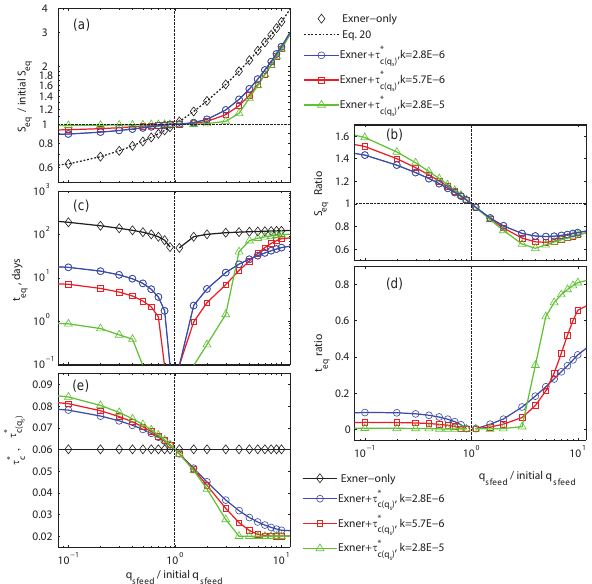
were c( q s ) Figure 8. Morphodynamic model sensitivity to sediment supply perturbations and k . All models started at the same equilibrium con- dition as shown in Figs. 6 and 7. (a) Slope adjustment, normalized by the initial equilibrium slope. The correspondence of Eq. (20) and the morphodynamic model calculations demonstrate that the models did asymptotically attain equilibrium slopes. (b) S eq ratio is the ratio of equilibrium slopes of the Exner + τ ∗ model di- c( q s ) vided by S eq for the Exner-only model, to show the relative af- fect that τ ∗ c evolution has on equilibrium slopes. (c) Equilibrium timescales for model adjustment. (d) t eq ratio is the ratio of t eq for the Exner + τ ∗ model divided by t eq for the Exner-only model. c( q s ) Values are lower than 1, indicating that the τ ∗ c evolution has a large influence on equilibrium timescales. (e) Evolution of τ ∗ c( q s )